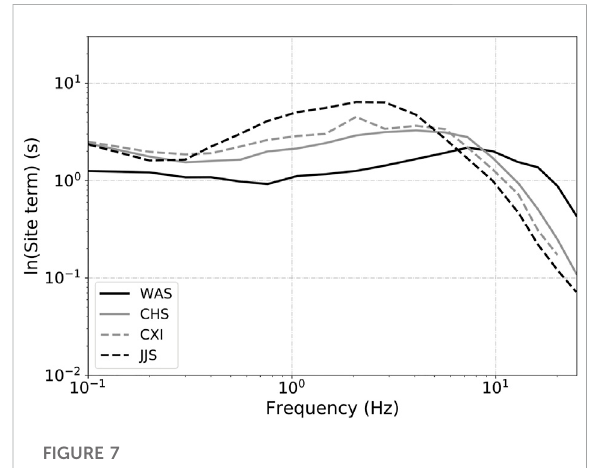
FIGURE 7 Comparison of site responses versus frequency of four stations WAS, CHS, CXI, and JJS in the Sichuan Basin. The thicknesses of sediments underlying stations WAS, CHS, CXI, and JJS are 2.0, 5.2, 7.7 and 10.0 km respectively. The value of sediment thickness is estimated as the thickness of the Cenozoic and Mesozoic sedimentary sequence based on results from Wu et al. (2016).